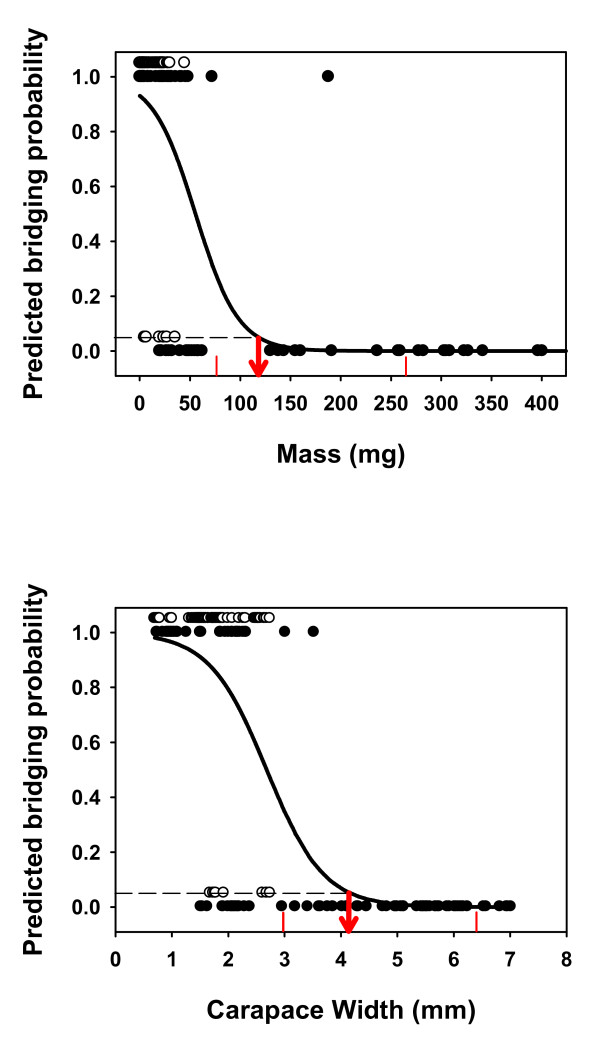
Effects of spider size on the probability of bridging. Plots show the probability of bridging predicted by logistic regressions (continuous line) using either a) body mass or b) carapace width as predictor variables. Each dot corresponds to the trial of one single individual (females solid circles, males empty circles). To distinguish between males and females, successful bridging takes the value of 1 for females and 1.05 for males, while unsuccessful bridging takes the value of 0 for females and 0.05 for males. The red arrows show the threshold beyond which the predicted probability of bridging is les than 5%, and the red small vertical lines mark the limits of the confidence interval for this threshold.